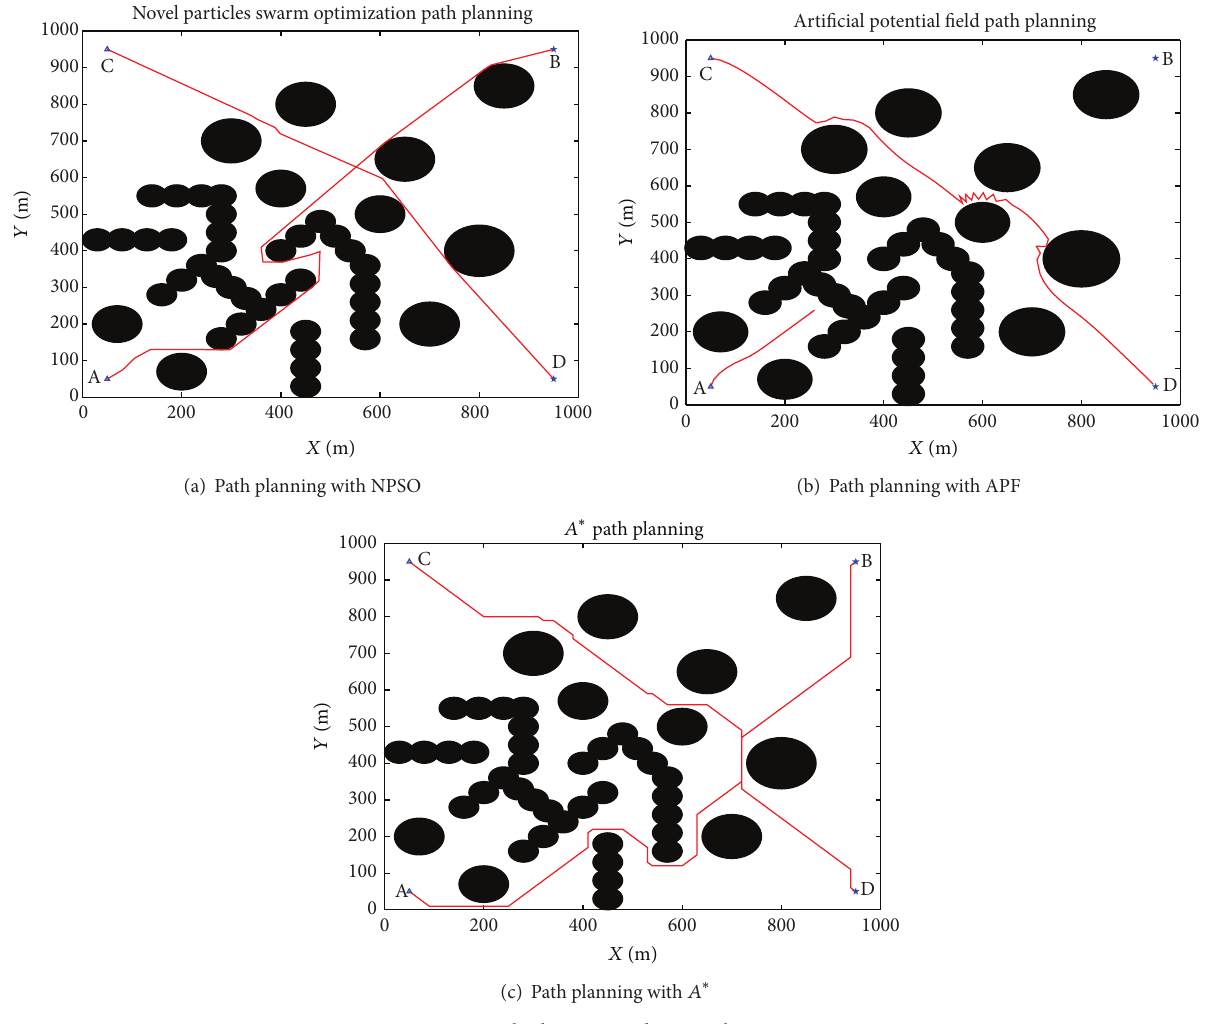
Figure 7: UUV path planning under complex environment.